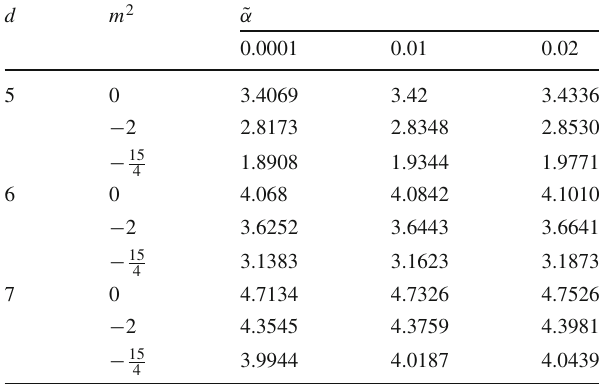
Table 4 Analyticalvalues of criticalparameters (cid:2) 0 for different values of ˜ α, d and m